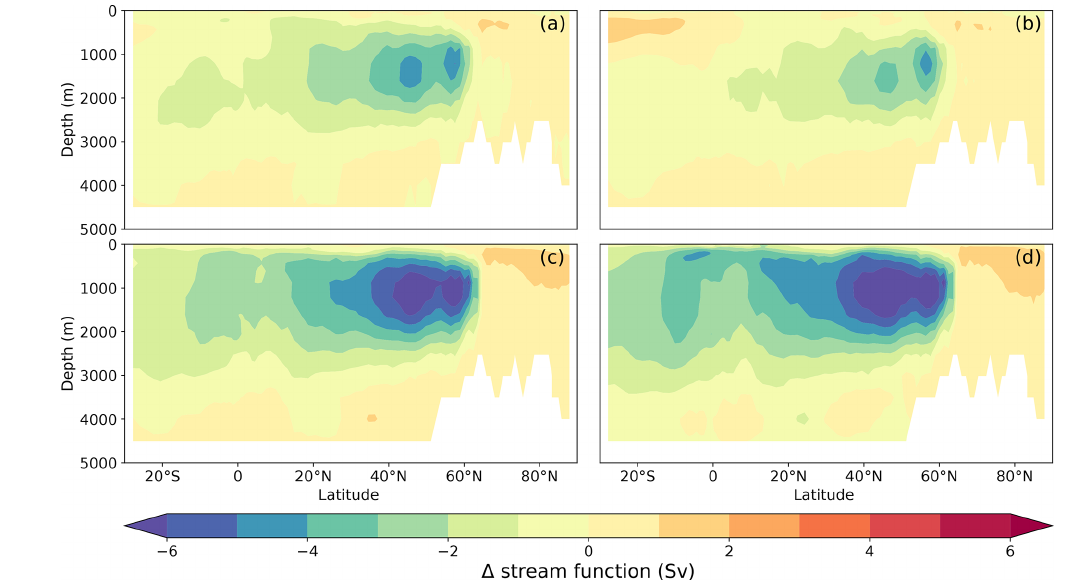
Figure B1. Stream function difference between future scenarios (2041–2070) and historical simulation (1976–2005) for the MJJAS season. The future scenarios are (a) RCP8.5, (b) WAIS3m, (c) GrIS1m and (d) GrIS3m.